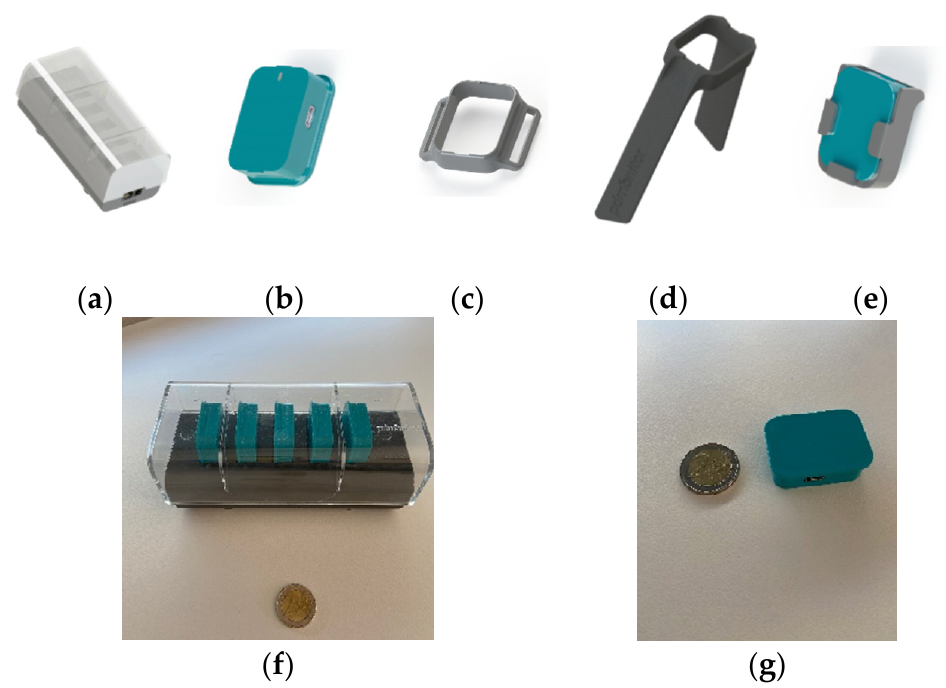
Figure 1. The PDMonitor ® : ( a ) SmartBox; ( b ) MD; ( c ) StrapFrame; ( d ) Wristband; ( e ) ClipFrame; ( f ) SmartBox in comparison to a coin of EUR 2; ( g ) MD in comparison to a coin of EUR 2.